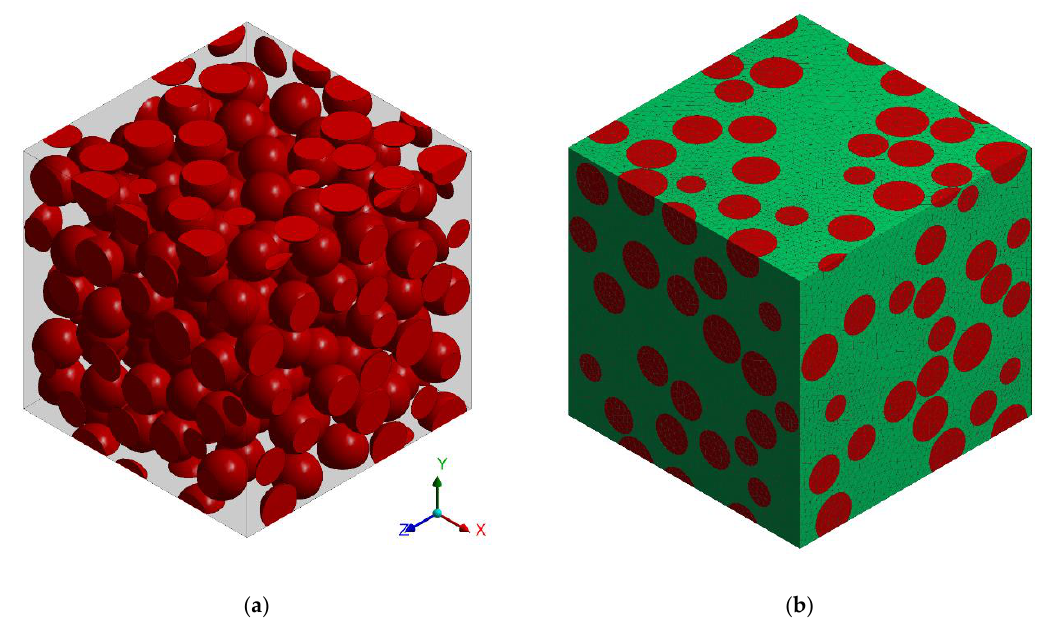
Figure 5. The representative volume element (RVE): ( a ) geometrical model; ( b ) finite element mesh.